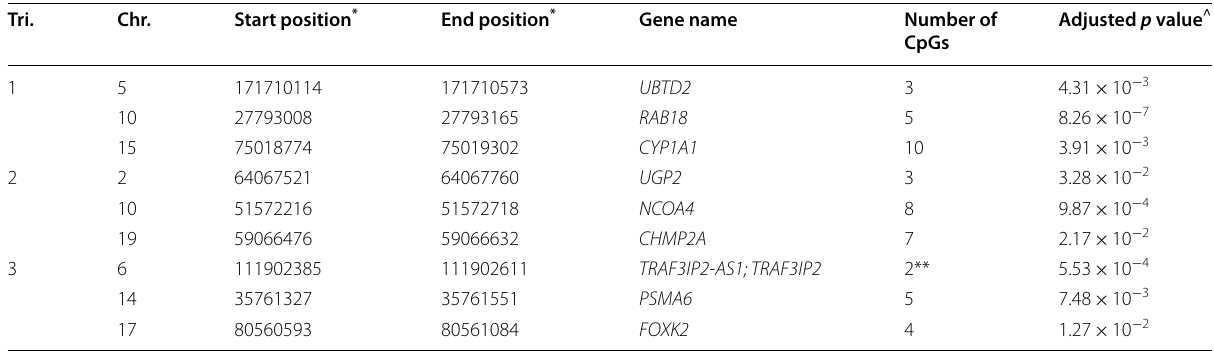
Table 3 Discovery phase differentially methylated regions with adjusted p values less than 0.05 for each trimester